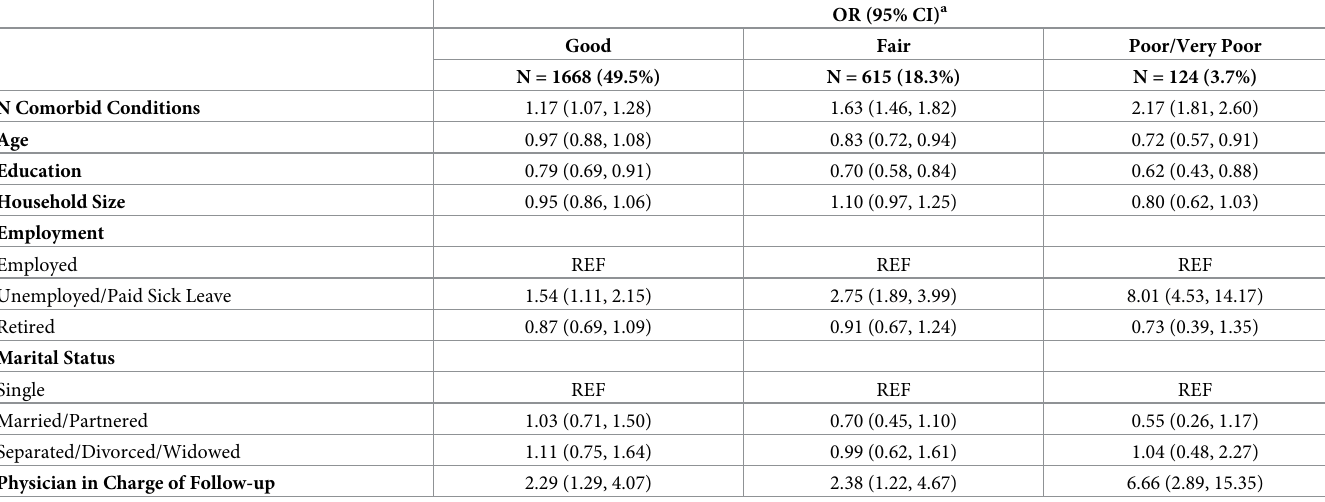
The majority of women reported either very good (29%) or good (50%) emotional health; with only 18% and 4% reporting fair and poor/very poor emotional health, respectively (Table 3). As the number of chronic conditions increased, the odds of reporting worse Table 3. Association between the number of comorbid conditions and emotional health among breast cancer survivors in the Transitions Study using multinomial logistic regression.